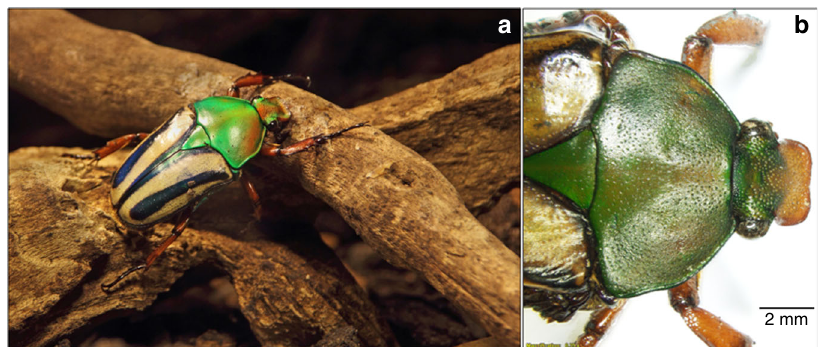
Fig. 1 The African Flower Scarab ( Eudicella gralli ). a Photograph of a female Flower Scarab. The iridescent coloration is caused by optically active layers within the cuticle. Spectroscopic investigation of the surface chemistry of the scarab cuticle is challenging, because of the curvature and multilayered complexity of the material. b Details of the front part of E. gralli and the dorsal head protrusion used to dig through